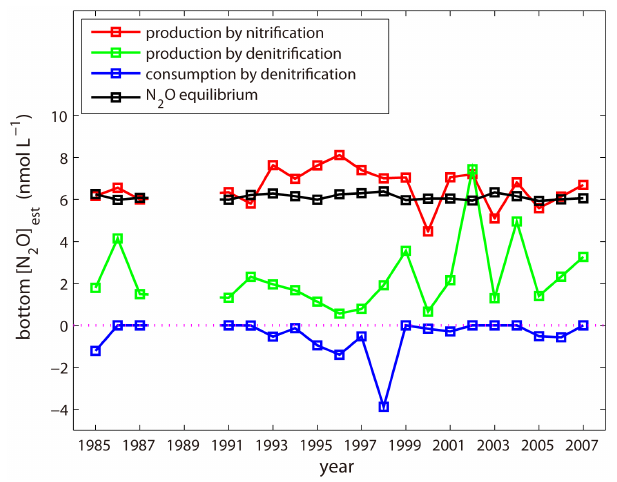
Fig. 3. The individual contributions of nitrification (red squares, production), denitrification (green squares, production), denitrifi- cation (blue squares, consumption), and N 2 O equilibrium (black squares) to the bottom-water N 2 O concentrations in the nGOM from July 1985 to 2007.